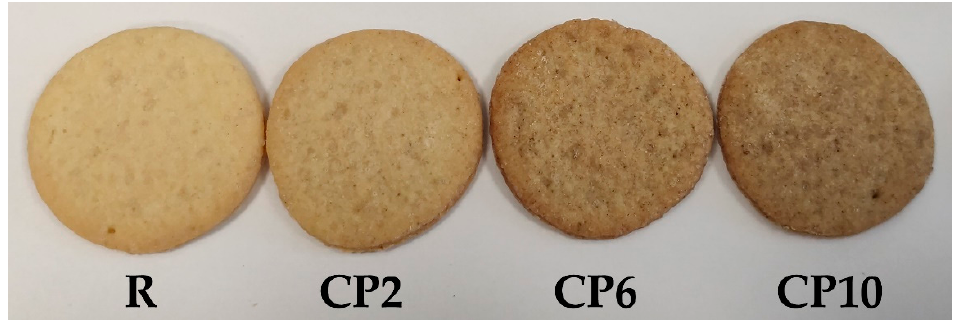
Figure 2. Biscuits with CP: R—reference biscuits; CP2, CP6, and CP10—biscuits with 2%, 6%, and 10% of wheat flour replacement with CP, respectively.